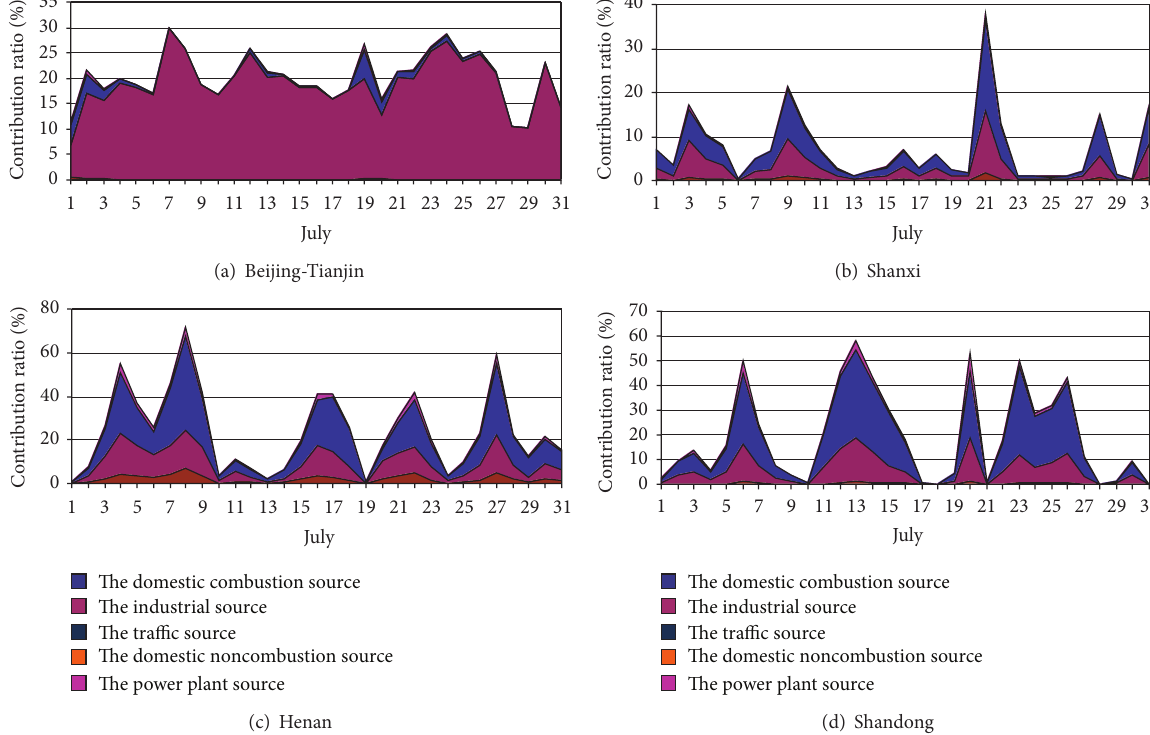
Figure 5: Contribution ratios of daily average PM 2.5 concentration from sector sources of the surrounding areas to Xingtai in July